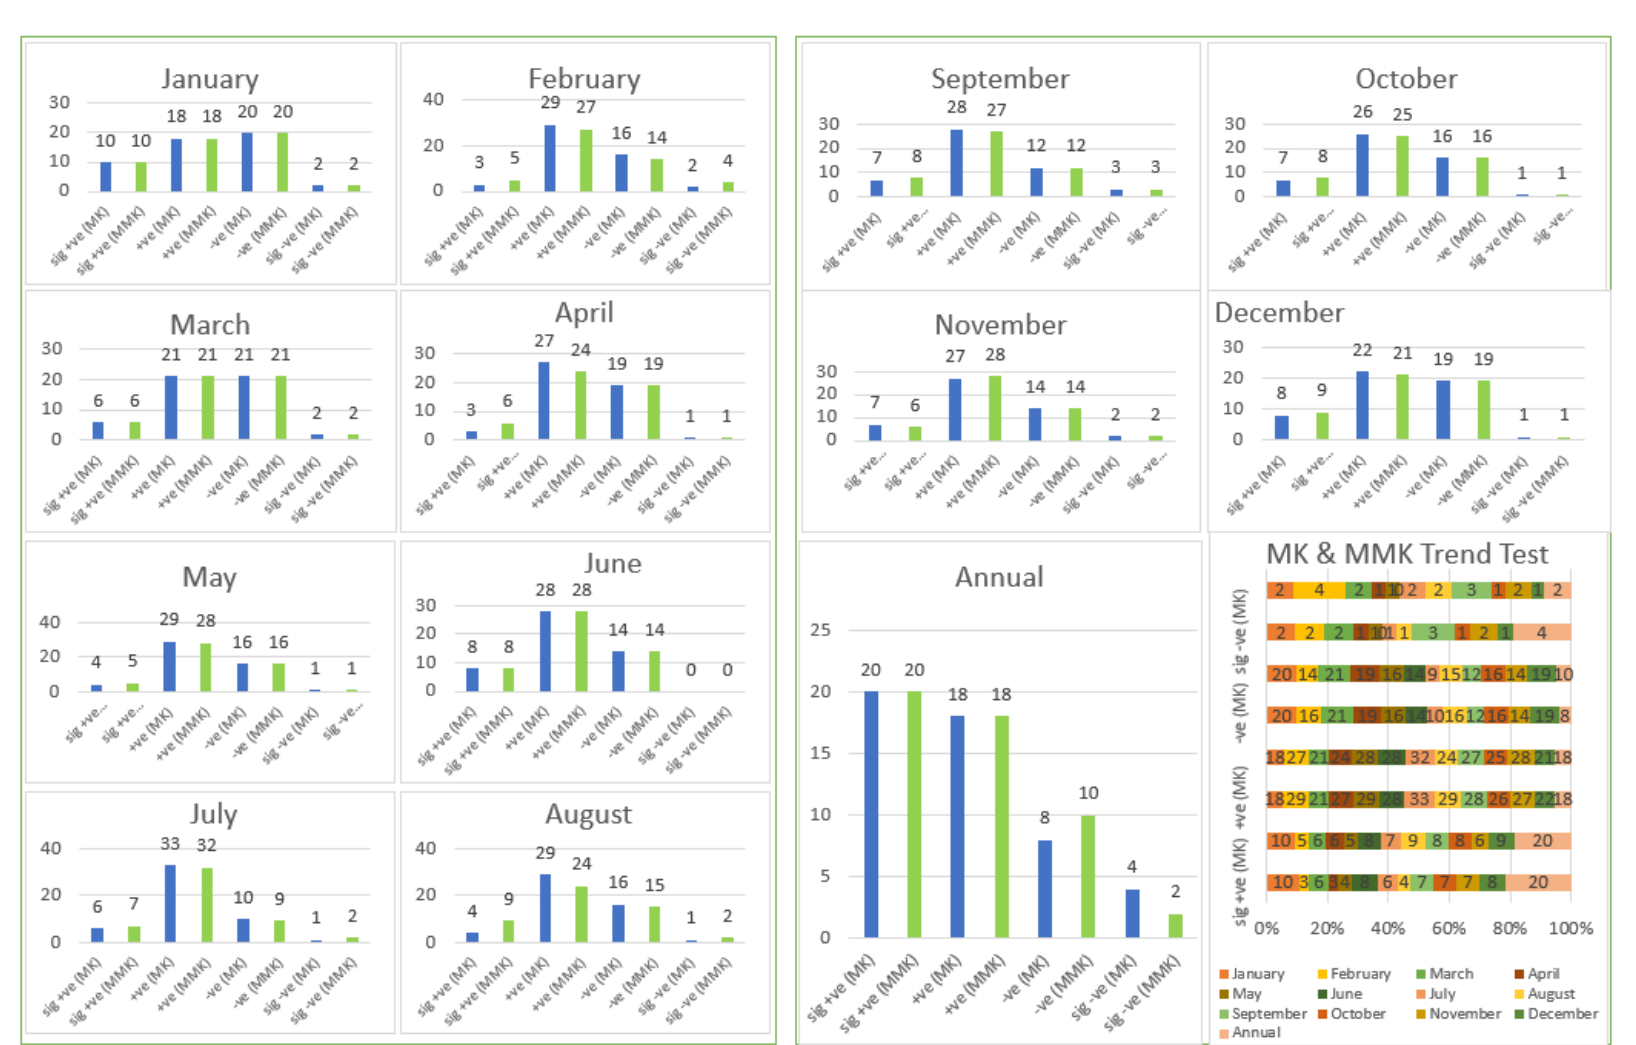
Figure 7. Z-Statistics of Mann–Kendall (MK) and Modified Mann–Kendall (MMK) value .